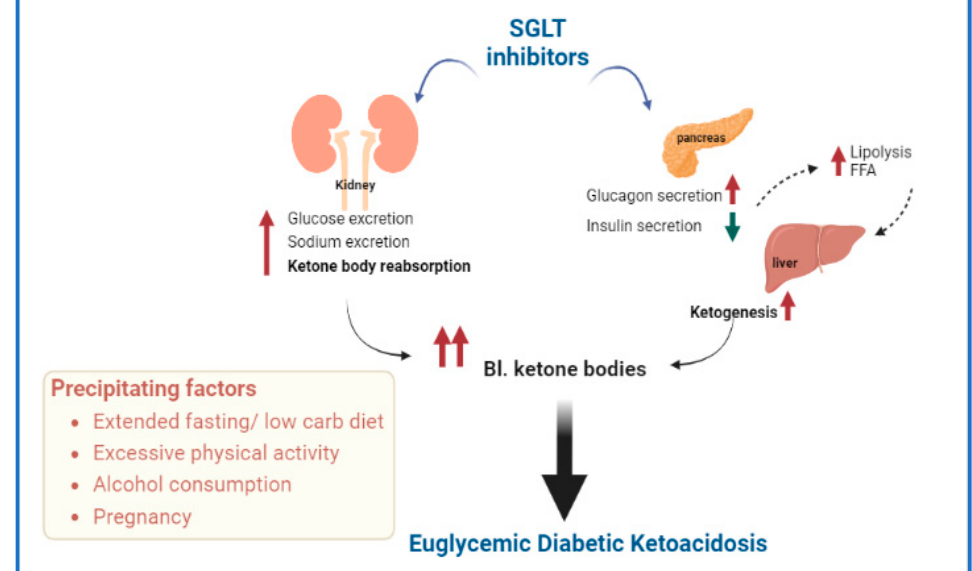
Figure 3. Schematic representation of possible mechanisms involved in the development of euglycemic diabetic ketoacidosis (DKA) associated with sodium glucose transporter (SGLT) inhibitors. Precipitating factors are also included. Abbreviations—FFA: free fatty acids, Bl.: blood.